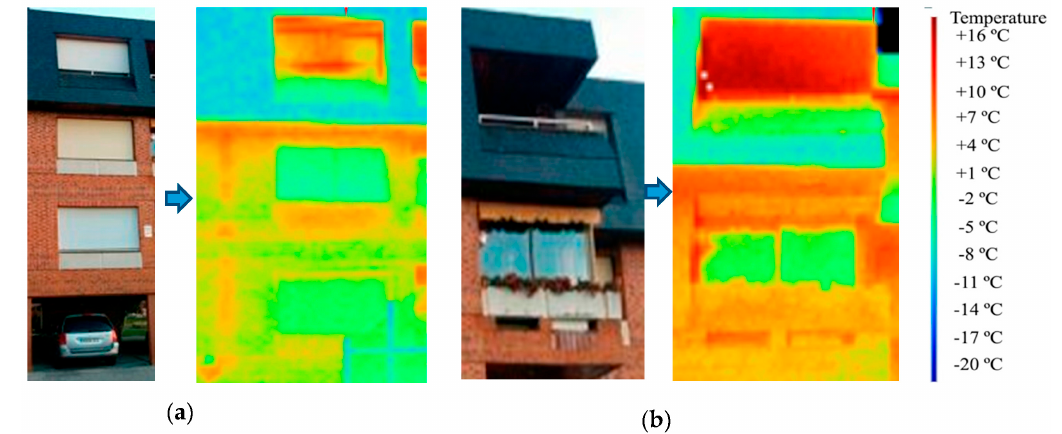
Figure 6. Building thermography (℃). ( a ) Central zone; ( b ) End zone.